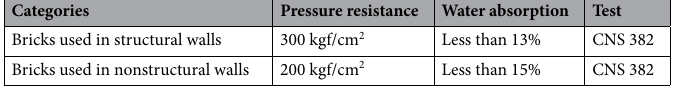
Table 6. Brick categories.